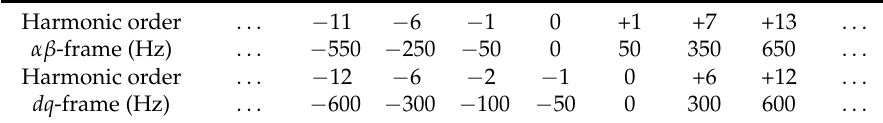
Table 1. Dominant components of the grid